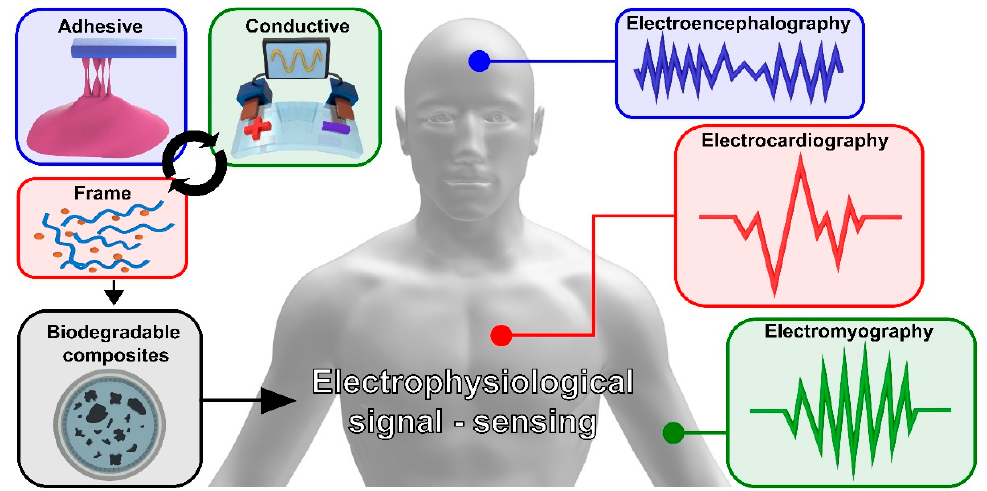
Figure 4. A 3D schematic of human electrophysiological signals and biodegradable composite polymer electrodes.